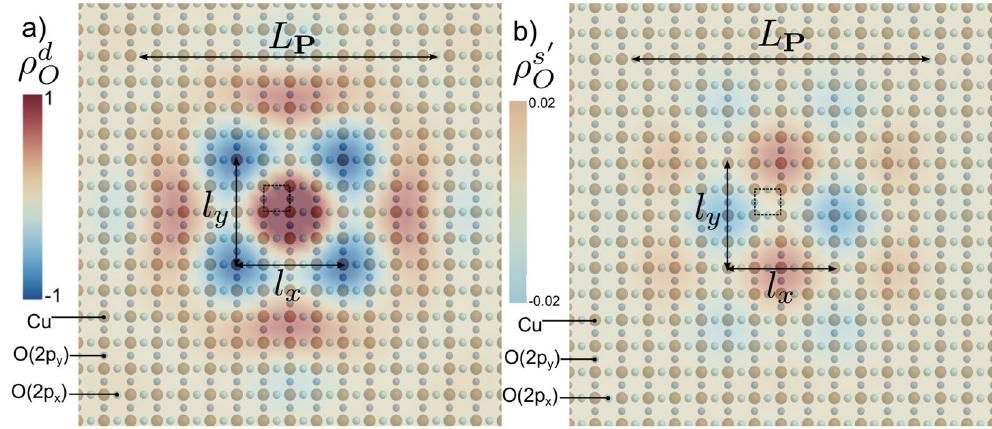
Figure 3. Charge density on O atoms. ( a ) Visualization of the d -wave component of the charge density on oxygen atoms ρ Od normalized to ± 1 value in the real space. ( b ) Visualization of the s ′ -wave component of charge density on oxygen atoms ρ ′ Os , normalized to the maximal value of ρ Od in the real space. In both ρ Od and ρ ′ Os , we see an incommensurate charge order developing on oxygen atoms with wave length π = l Q 2 / and π = l Q 2 / . x x y y The elementary cell of the square lattice is represented by the dashed square. The Fig. 3(a,b) have been determined by evaluating the formula (10). The summation over the momentum k has been performed in the FBZ while the summation over P vectors has been done over two-hundred ordering vectors P . We choose a distribution of vectors P around the Fermi surface. The extension in momentum of these distribution is the one presented in Fig. 2(a). The calculation has been done considering the electronic dispersion for Bi2212 compounds used in refs 33, 37 at hole doping p = 0.08. The coherence length of the particle hole pair is of order of the length between two Copper site ξ ≈ a while the size of the patch is larger, L P ≈ 10 a 0 . 0